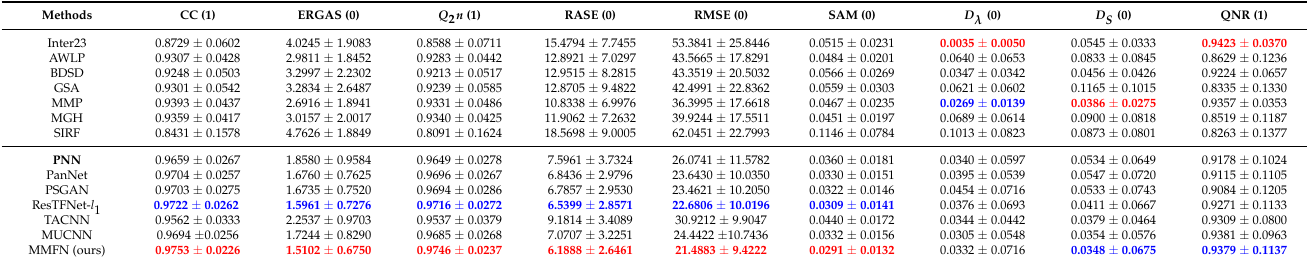
Table 4. Average quantitative performance on the WorldView-2 dataset. The best and second best performances are shown in Red and Blue ,